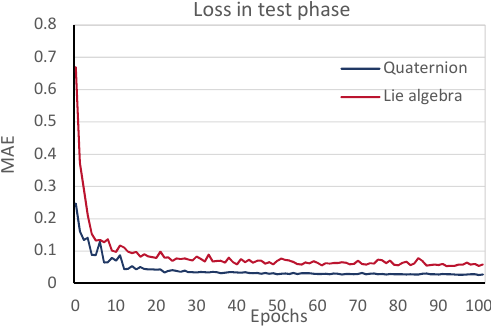
Figure 5. Testing loss vs. iteration.